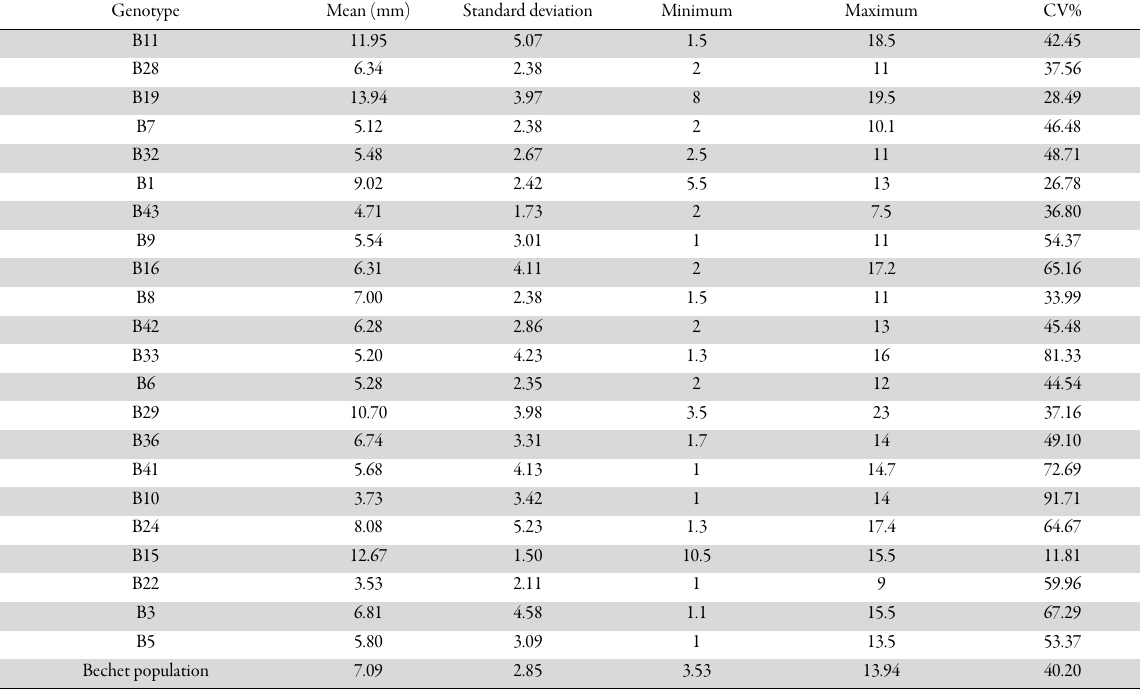
Table 2. Statistical analysis of annual growth rings in genotypes in Bechet populations Genotype